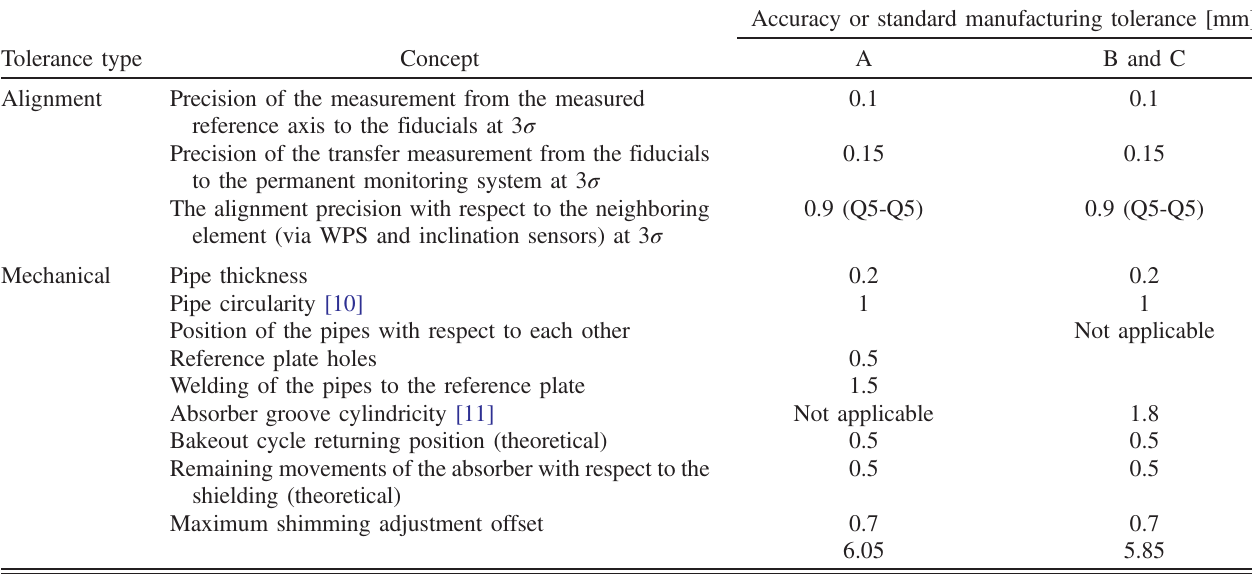
TABLE II. Summary of the mechanical and alignment tolerances used to determine the beam aperture. All tolerances are given considering the diameter, with respect to the zero line between the beam lines and for A, B, and C locations described in Fig. 6. Accuracy or standard manufacturing tolerance [mm] Tolerance